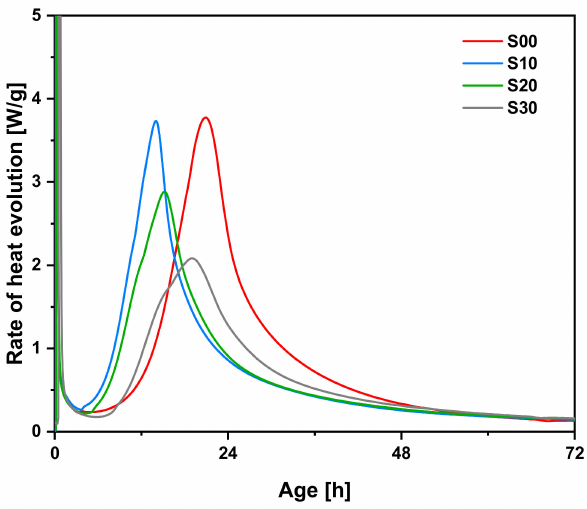
Figure 3. Rate of heat evolution of cement mortars blended with SF up to 72 h of